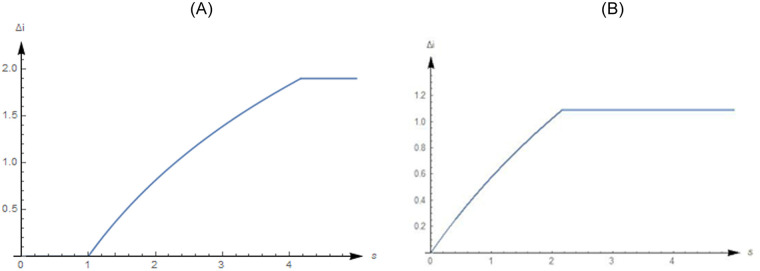
A. Crowding-in effect when iqq > 0 and p = 1. B. Crowding-in effect when iqq > 0 and p = 3.